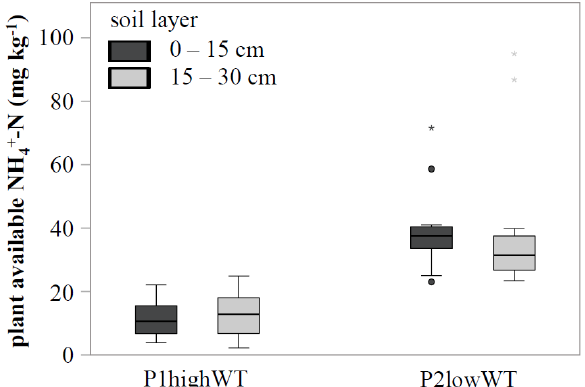
Figure 5. Contents of plant available NH 4+ -N in soil samples (dry mass basis) of the upper and lower soil layers. P1highWT: sampling station with mean water table 6 cm below ground surface; P2lowWT: sampling station with mean water table 17 cm below ground